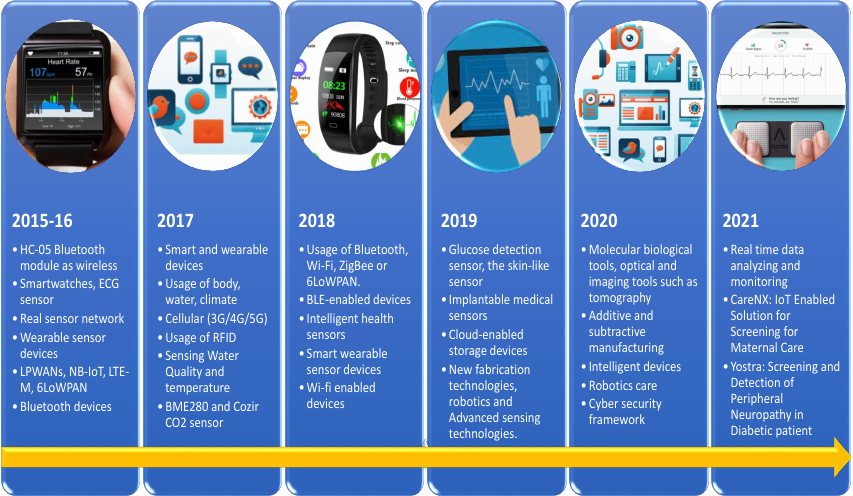
Figure 2. Technological enhancement of IoT-based healthcare.